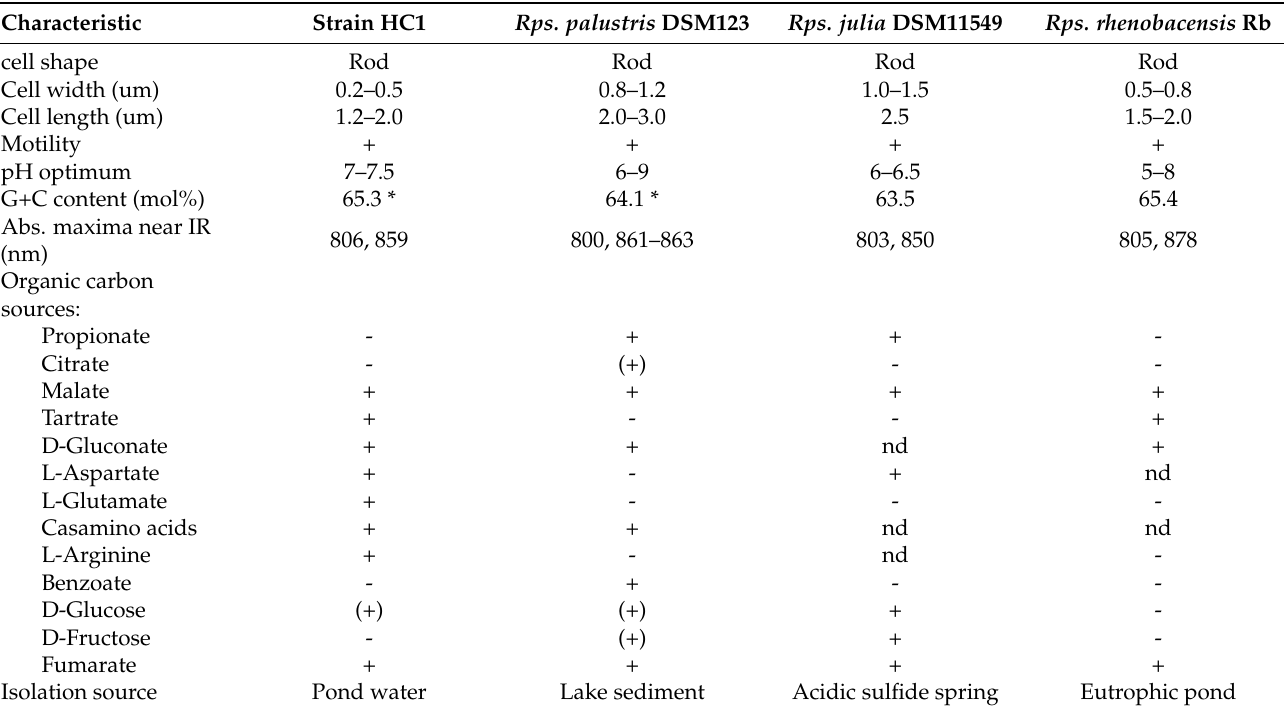
Table 1. Physiological growth characteristics of strain HC1 as compared to the type strains of